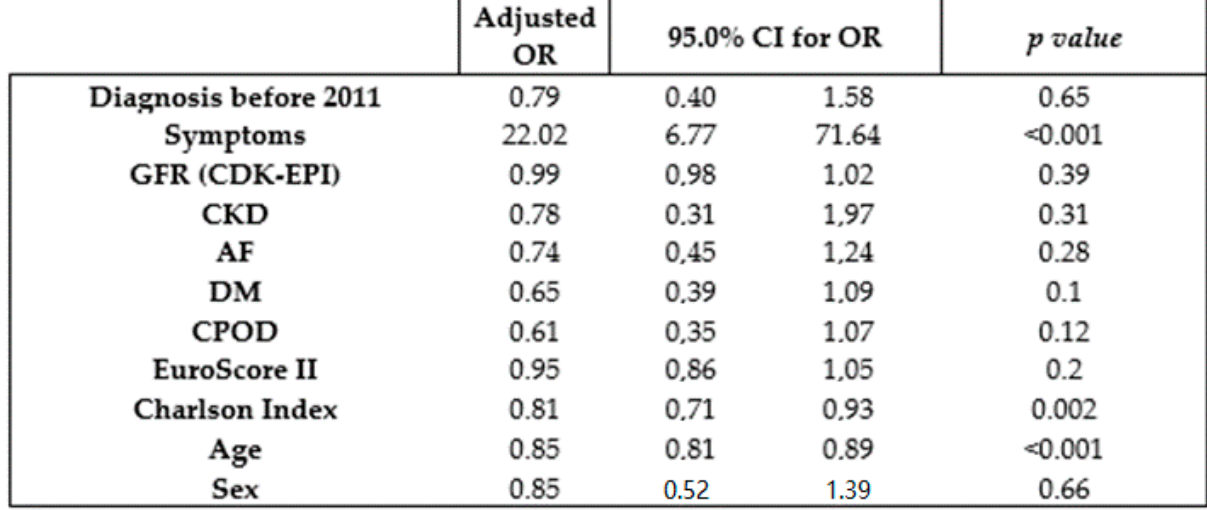
Figure 1. Binary logistic regression model used for multivariate analysis of predictors of AVR.